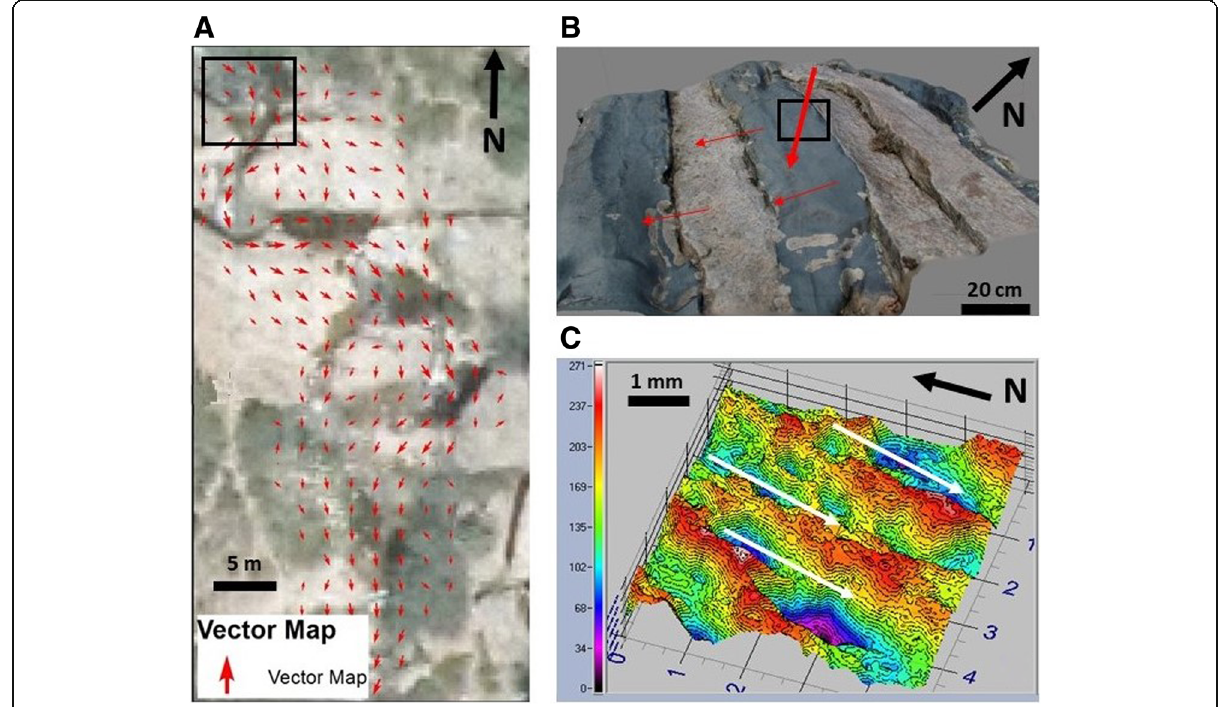
Fig. 12 An example of how different morphometric techniques operate indicating flow directions (red arrows, white arrows in c ) at different scales. Macro- scale DEM ( a ) and mesoscale DEM ( b ) from SfM and 5×5mm microscan obtained with optical microrugosimeter on the stoss slope of a microdiorite